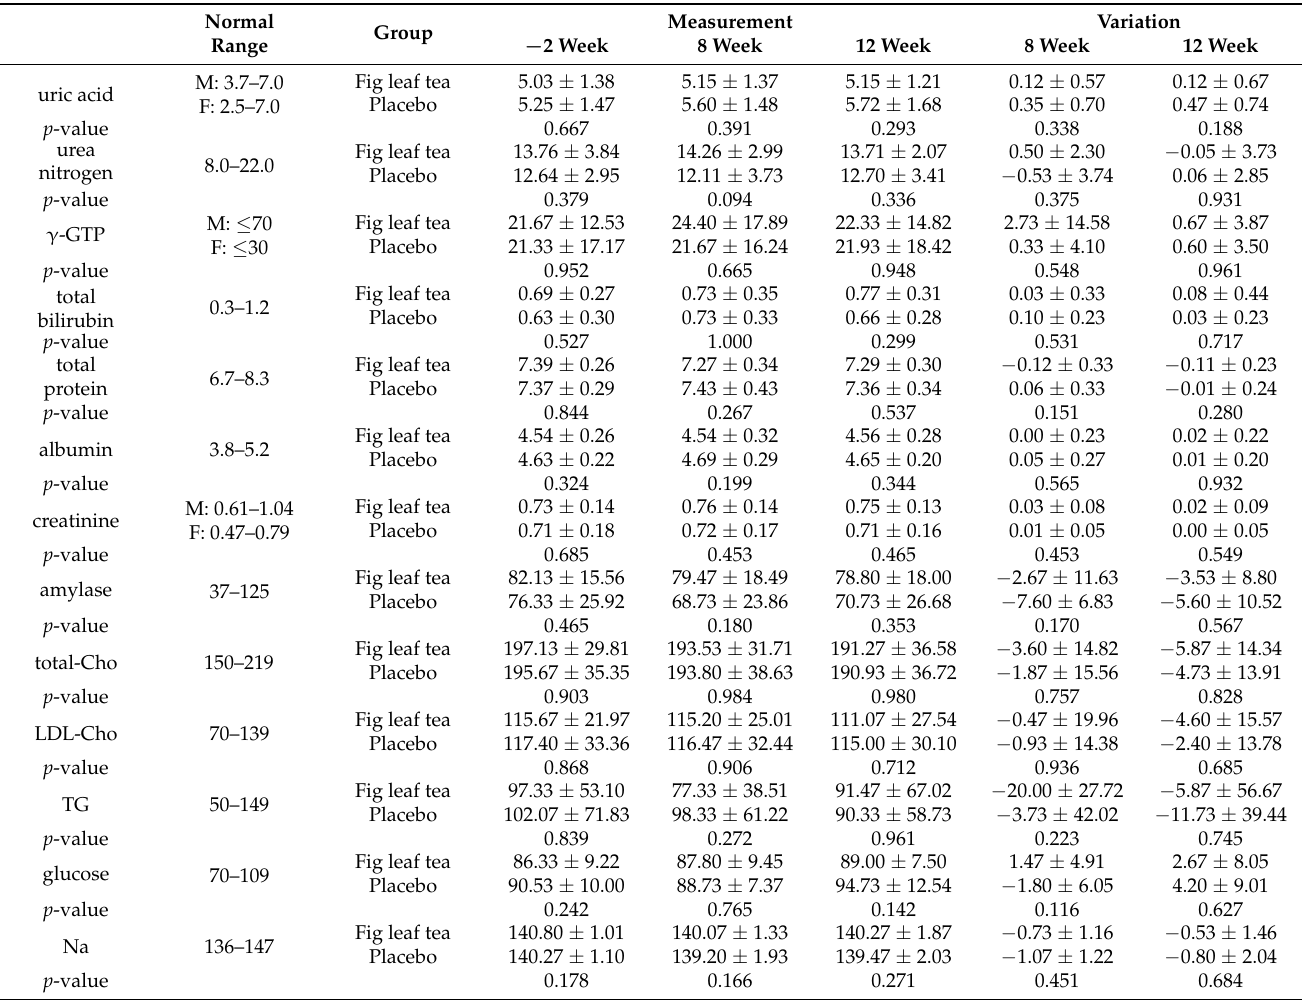
Table 8. Transition in safety